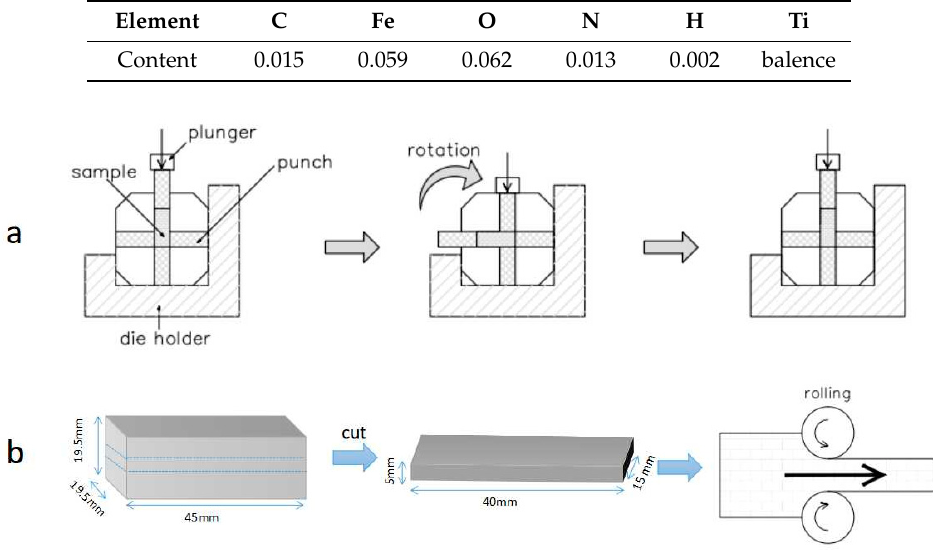
Figure 1. The diagrammatic drawing of ( a ) RD-ECAP (rotary-die equal-channel angular pressing) and ( b ) cold rolling.